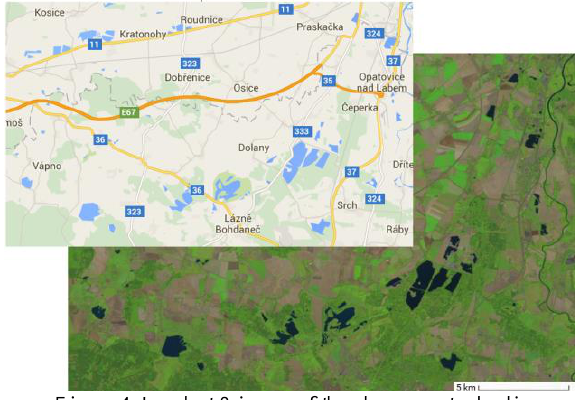
Figure 4. Landsat 8 image of the chosen water bodies